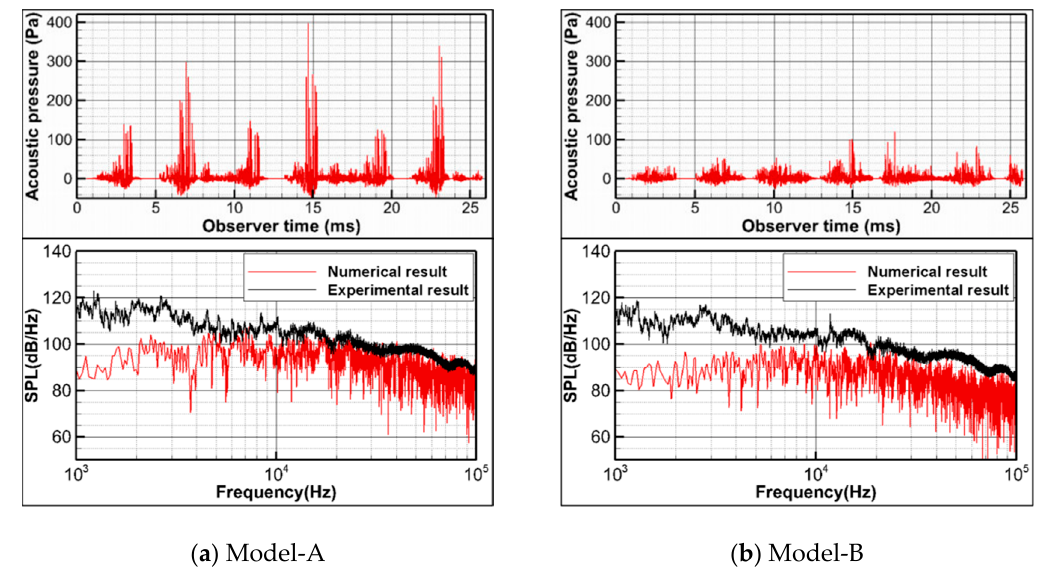
Figure 22. Predicted acoustic pressure due to tip vortex cavitation in the time and frequency domain for ( a ) Model-A and ( b ) Model-B.